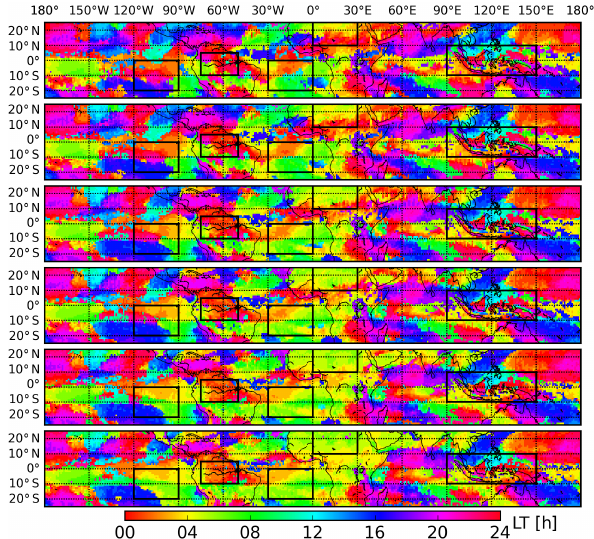
Figure 14. Diurnal peak time in local time for RH I based on Fourier series fit for the months of December and January. Depicts from top to bottom are for SAPHIR channels 1–6,